Question: Briefly state, in one sentence, what is plotted here.
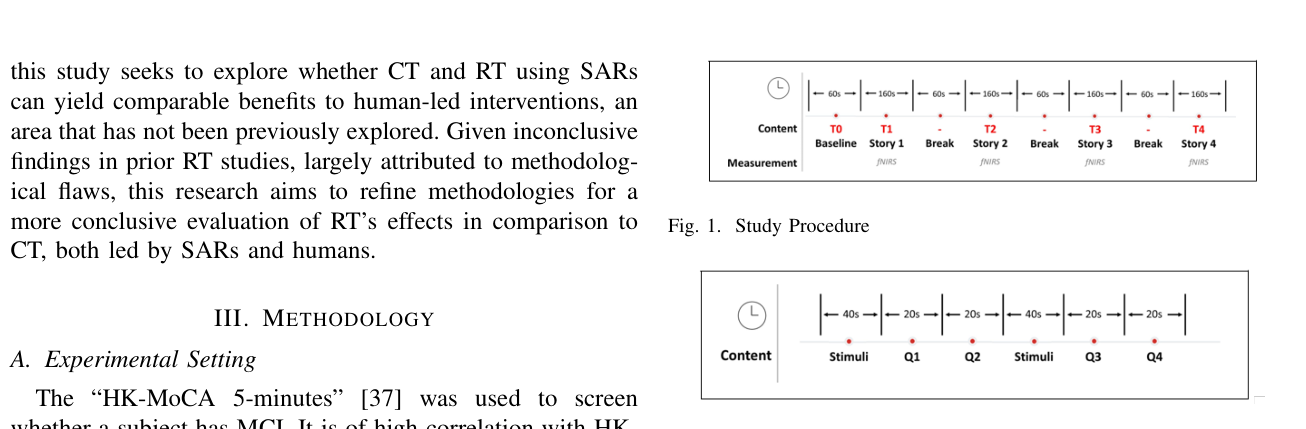
Answer: Procedure of the “Story” session Procedure of each story sessions (T1-T4). “Stimuli” refers to the verbal stimuli either given by a NAO robot or by a human. “Q1” to “Q4” are “Q & A” for the participants, each lasting for 20 seconds.